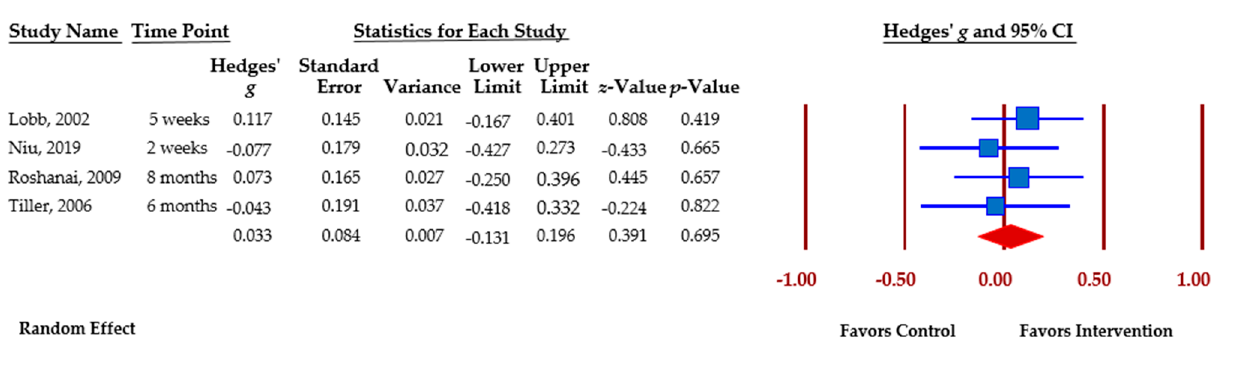
Figure 5. Anxiety. Figure 5. Anxiety.